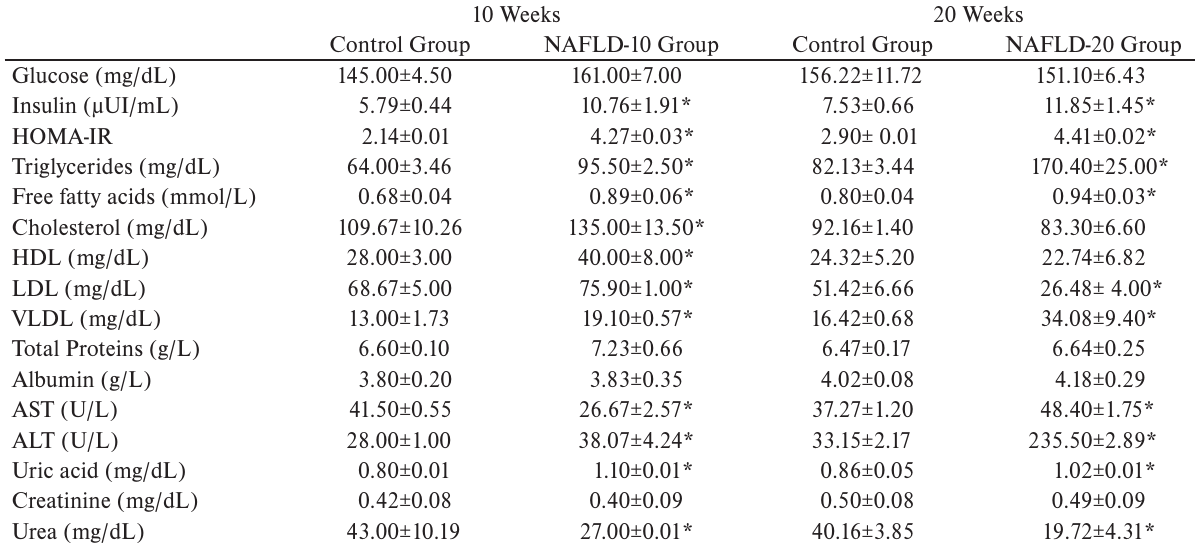
** Fig. 2. Distribution of adipocyte sizes in rats with abdominal obesity and non-alcoholic fatty liver disease (NAFLD). Percentage of adipocytes between 500 and more than 1501 µm 2 . (A) rats consuming sucrose for 10 weeks (NAFLD-10) and (B) rats consuming sucrose for 20 weeks (NAFLD-20); relative to control rats. *P <0.05 Table 2. Serum parameters in control (C) and sucrose-fed (NAFL) rats.